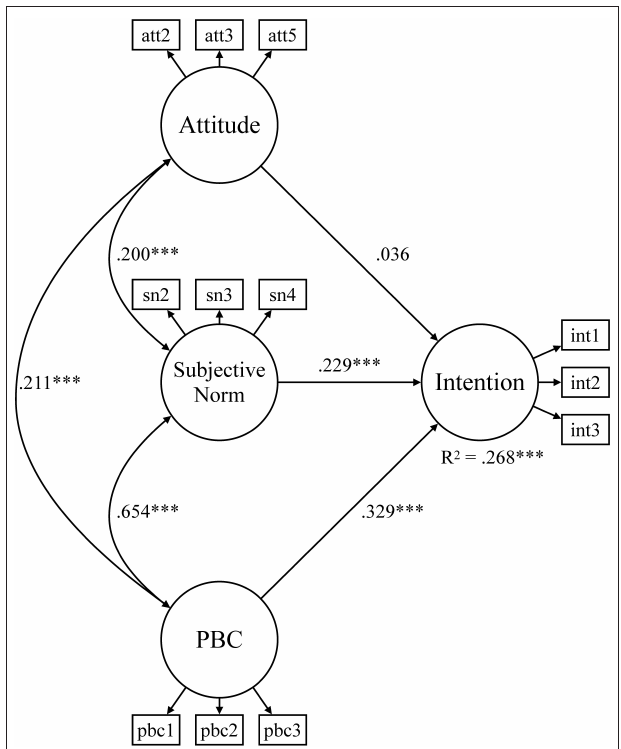
FIGURE 1 | Structural equation model for environmentally friendly behavioral intentions (full sample). PBC, perceived behavioral control; *** p < 0.001. FIGURE 2 | Structural equation model for environmentally friendly behavioral intentions of females. PBC, perceived behavioral control ; *** p <